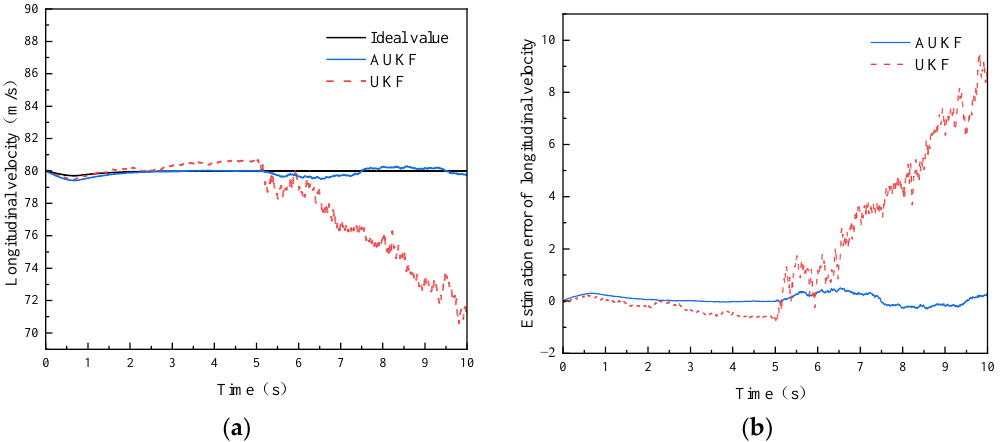
Figure 14. Simulation results of longitudinal velocity. ( a ) Comparison of estimated results and ( b ) comparison of estimated error.